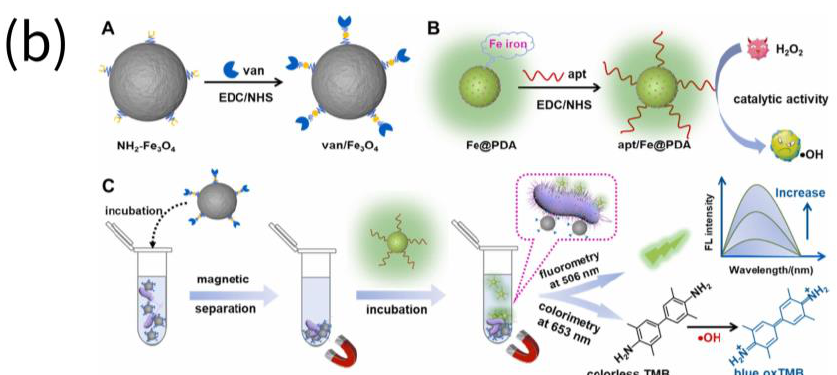
Figure 1. Assays for the detection of pathogenic micro-organisms in food by nanozymes. ( a ) E. coli O157:H7 were detected using mannose modified Prussian blue (man-PB) (reprinted with permission from [30], Copyright 2020, Elsevier). ( b ) Listeria monocytogenes were detected using Fe@PDA-based nanozyme (reprinted with permission from [32], Copyright 2022, Elsevier).